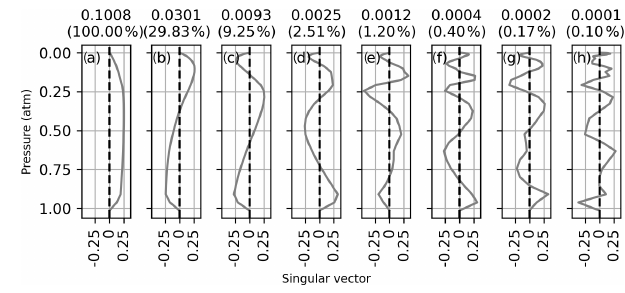
Figure D3. Same as Fig. D1 but for the TCCON2 window.